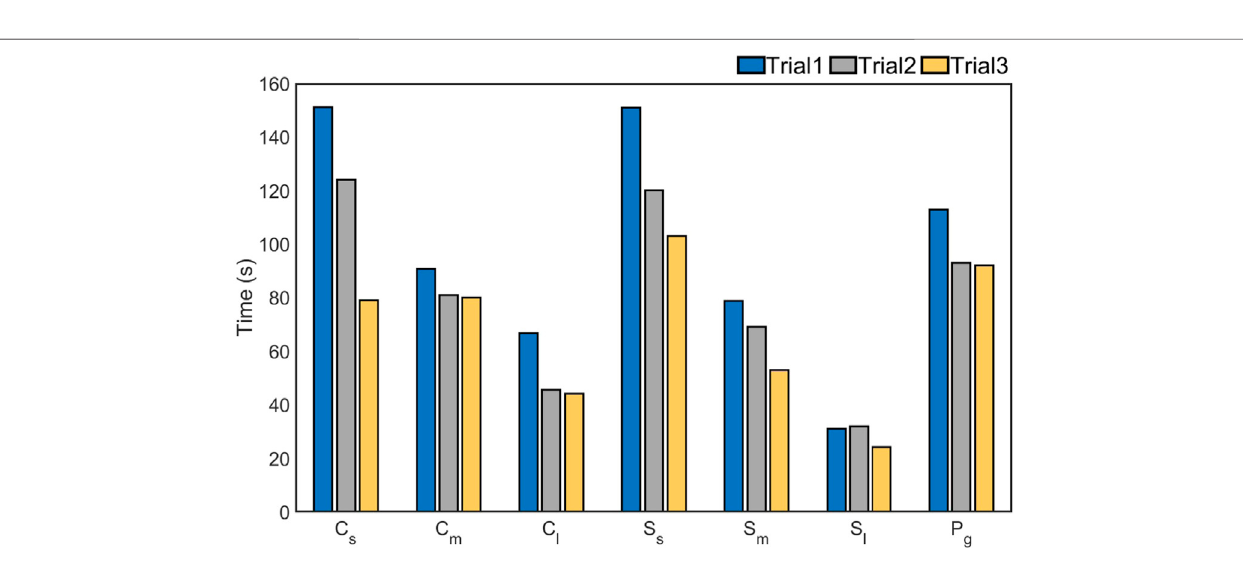
FIGURE9| Thecomparison oftime takenbytheMultiModal Paralleljawgrippertocomplete tasksforobjects ofvaryingshapes andsizes, ispresented.C,S,and P stand for Cylinders, Squares and Pegs respectively. The subscripts s, m, l, g, denote small, medium, large, and grooved parts respectively.